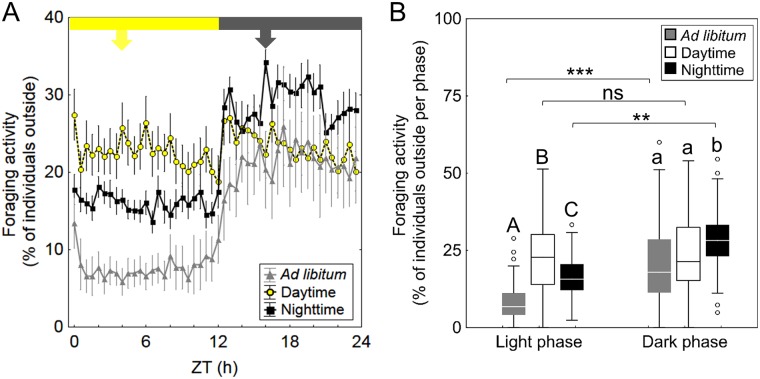
Effect of feeding regime on foraging activity in subcolonies.(A): Foraging activity in the course of 24 hours (mean±SE) for each feeding regime (grey: ad libitum feeding, n = 6 subcolonies; white: daytime feeding, n = 15 subcolonies; black: nighttime feeding, n = 12 subcolonies). (B): Foraging activity plotted separately for both the light and dark phases. Boxplots show medians (center lines) and interquartile ranges (boxes) for the three feeding regimes (grey: ad libitum feeding, n = 6 subcolonies; white: daytime feeding, n = 15 subcolonies; black: nighttime feeding, n = 12 subcolonies). Whiskers indicate the minimum and maximum values and open circles show outliers. Different capital letters show differences during the day phase and small letters show significant differences during the night phase between the feeding regimes (Kruskal-Wallis tests with Bonferroni correction, α = 0.017). Asterisks indicate differences between light phase and dark phase within every feeding regime (Wilcoxon signed-rank test with Bonferroni correction, α = 0.017). **: p<0.003; ***: p<0.0003; ns: p>0.017.